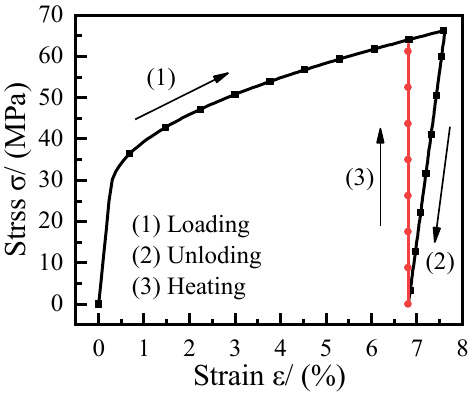
Figure 6. Stress–strain curves of SMA in different states.